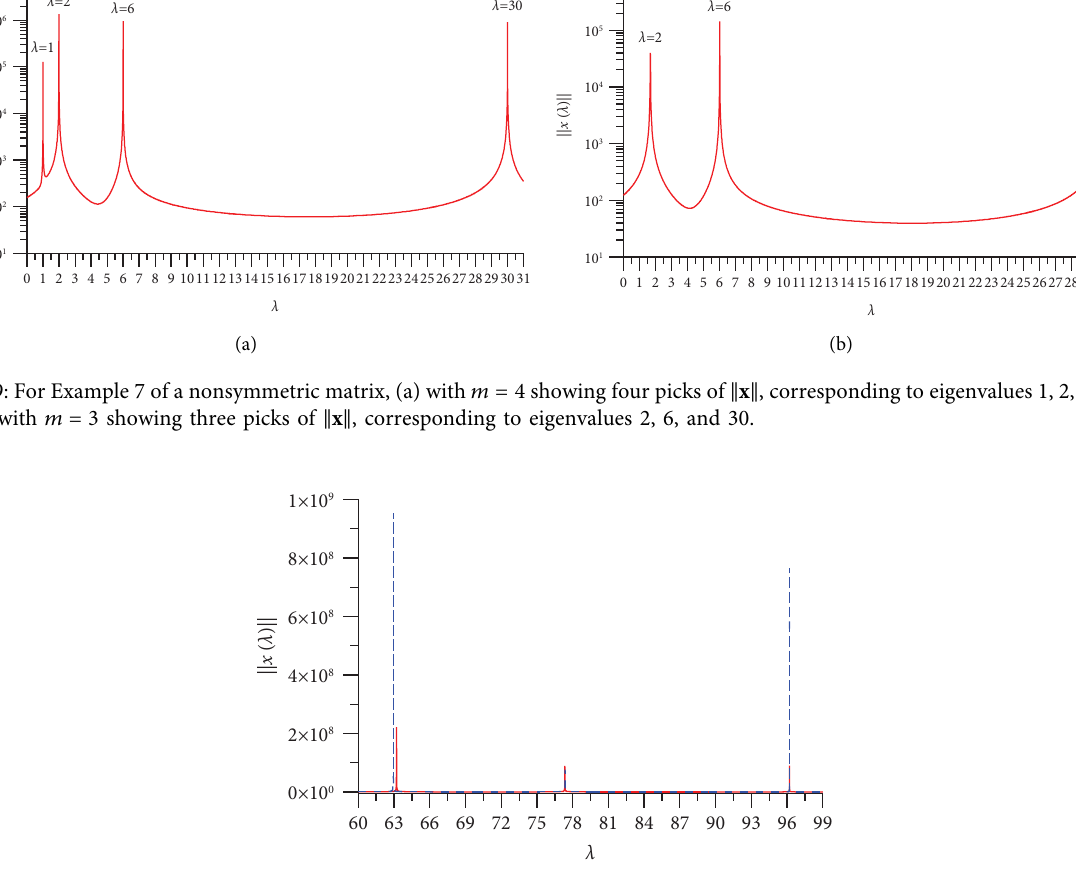
Figure 10: For Example 8 of the Frank nonsymmetric matrix with n � 30, showing three picks of ‖ x ‖ in the interval [60, 99], m � 20 solid line, and m � 8 dashed